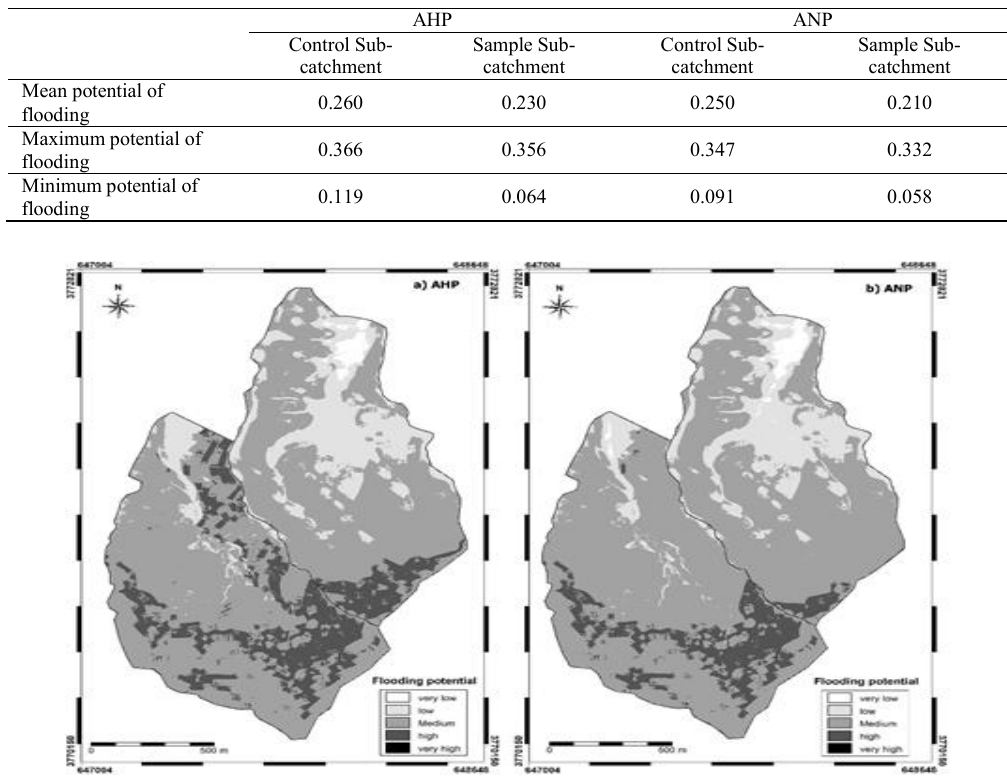
Fig. 6: The potential of flooding in the Control and Sample sub-catchments based on a)AHP